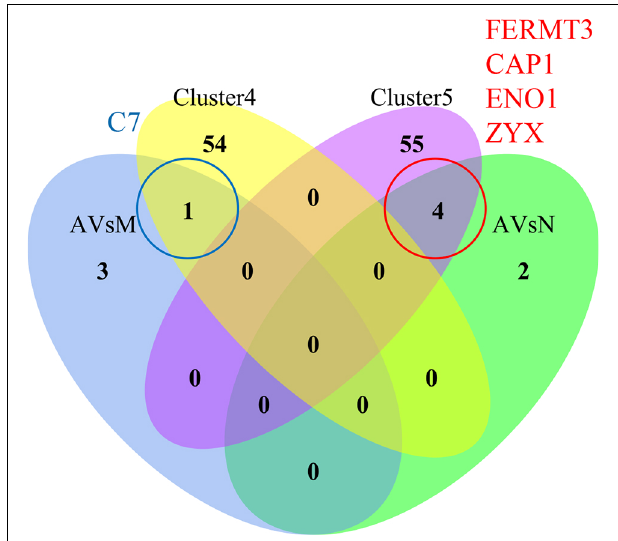
FIGURE 8 | Identification of key proteins in AD progression. The Venn diagram of Cluster 4 (yellow)/Cluster 5 (purple) bridge proteins and DEPs obtained through differential expression analysis between each pair of groups: AD vs. MCI (AVsM, blue)/AD vs. normal (AVsN, green). There is no intersection between Cluster 4/Cluster 5 and DEPs obtained through differential expression analysis of MCI vs. normal. The intersection between Cluster 4 and AVsM was C7, while the intersection between Cluster 5 and AvsN was FERMT3, CAP1, ENO1, and